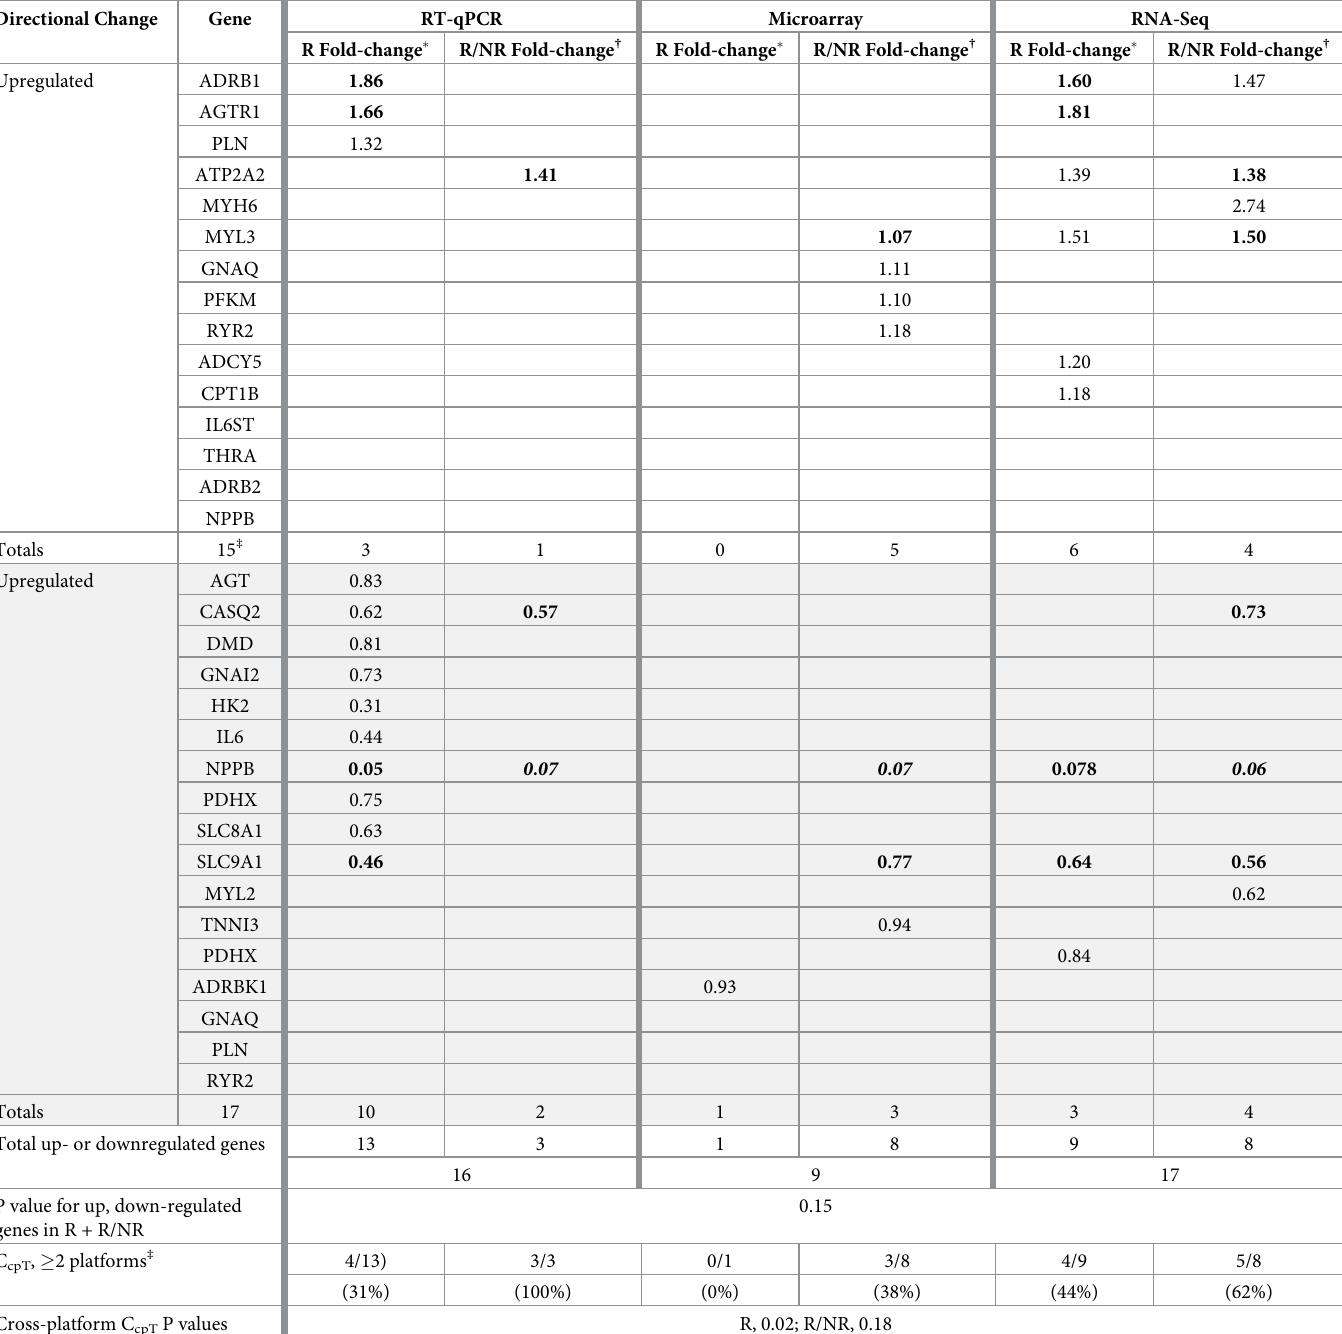
Table 2. Candidate genes in S-R cohort, mRNA expression fold changes from baseline within NR, R groups or comparison of R, NR fold changes (R/NR), changes with P <